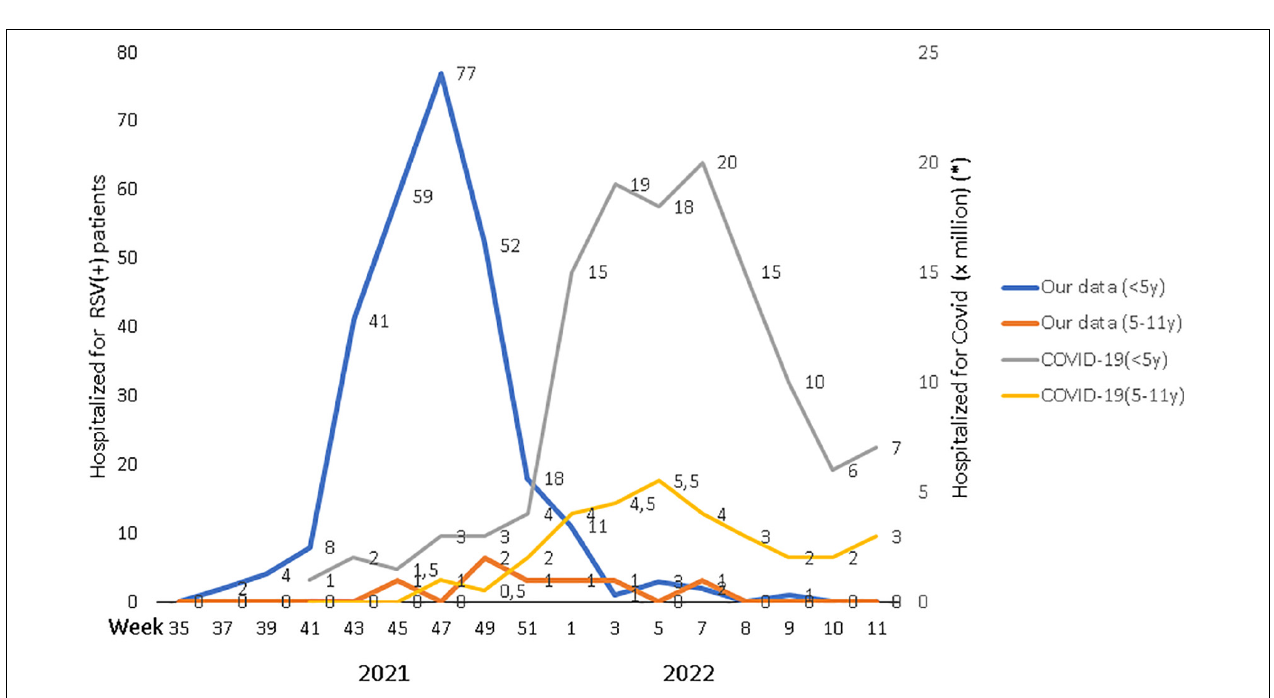
FIGURE 2 | Pediatric admissions for RSV + respiratory diseases by age vs. COVID-19 + admissions during the epidemic timeframe 2021–2022. COVID-19 admissions were collected from the national update of ISS (18).